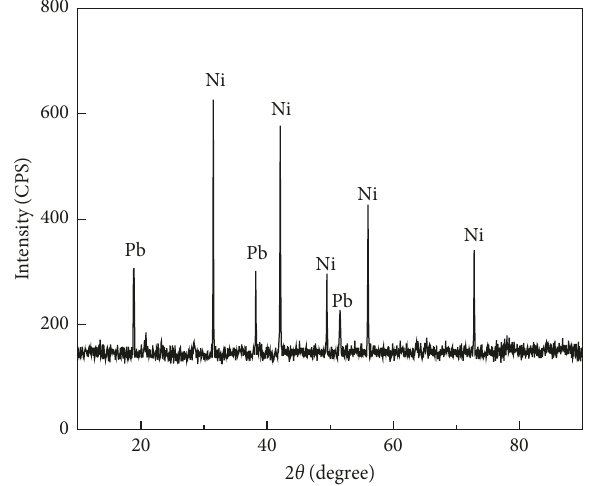
Figure 2: The XRD diffraction of Ni-5% Pb alloy hollow particles at